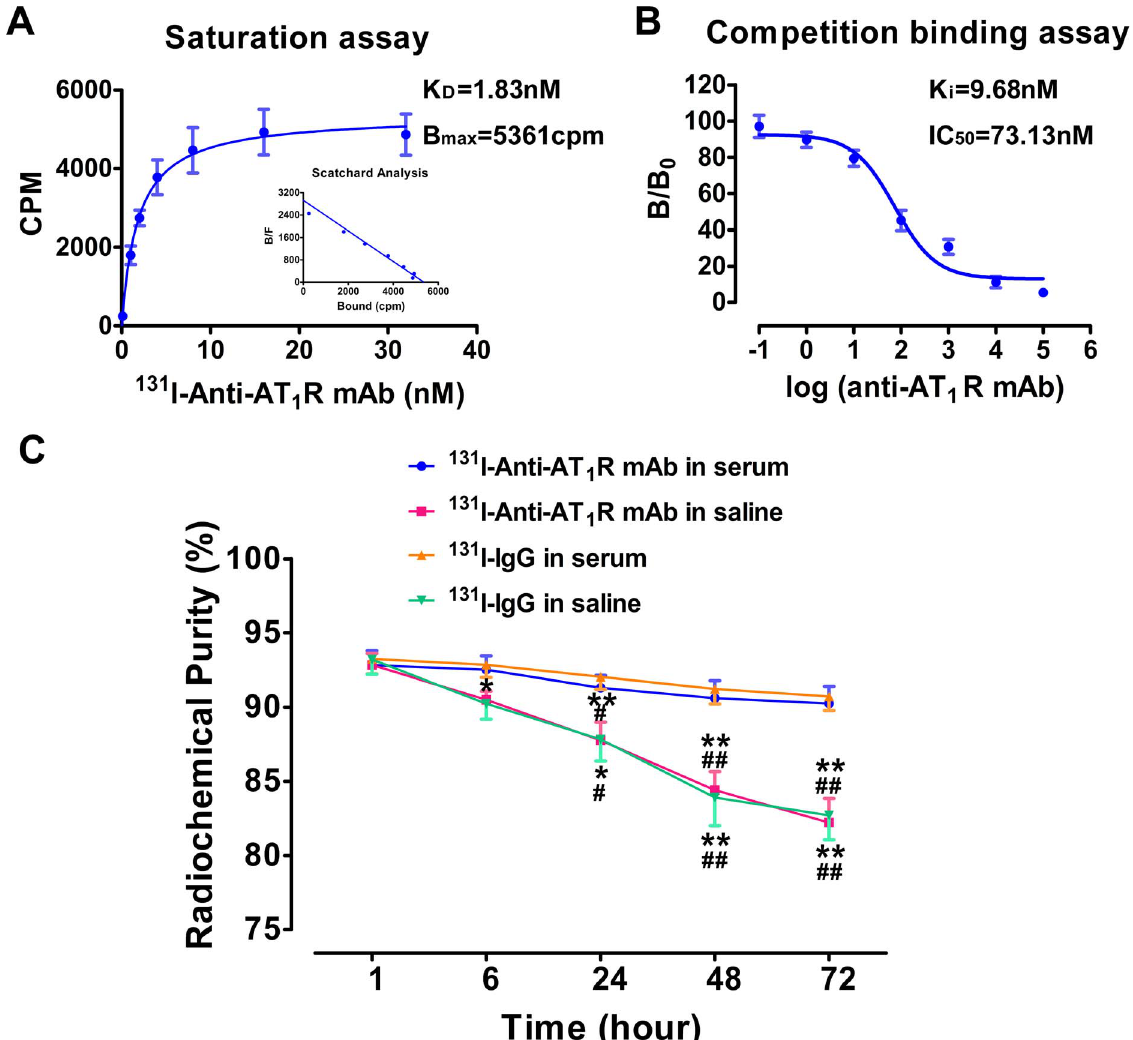
Figure 1. The affinity and stability of 131 I-AT 1 R mAb and 131 I-IgG. (A) The saturation assay of 131 I-AT 1 R mAb. K D , equilibrium dissociation constant; B max, maximum number of binding sites. (B) The competition binding assay of 131 I-AT 1 R mAb. K i , inhibitor constant; IC 50 , half maximal inhibitory concentration. (C) The radiochemical purity of 131 I-AT 1 R mAb and 131 I-IgG. * P , 0.05 and ** P , 0.01 vs. 1 hour; # P , 0.05 and ## P , 0.01 vs. the same time-point in serum.